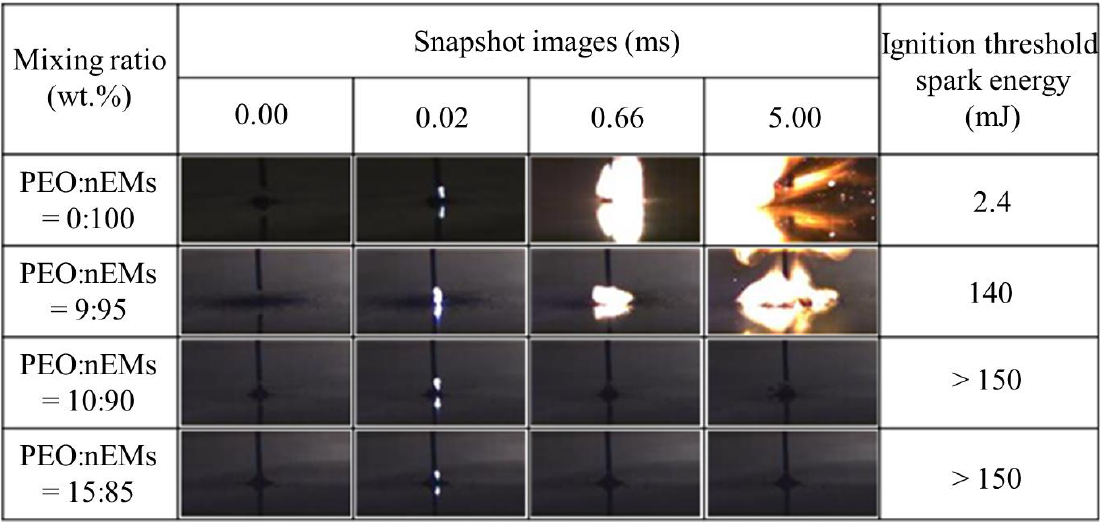
Figure 6. A series of still images of electrical spark ignition tests for PEO/nEM composites incorpo- rated with different PEO contents.